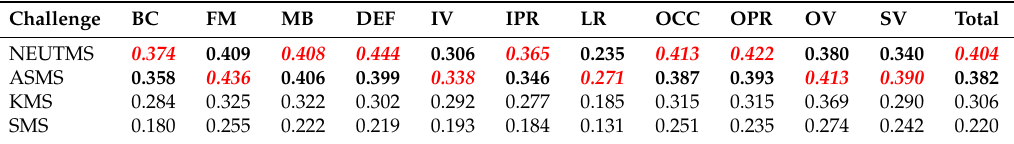
Table 2. AUC results of each tracker on sequences with different challenge for OPE.